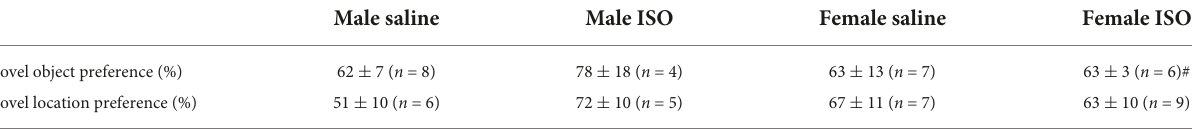
TABLE 3 Outcome of short-term memory tests in the different experimental